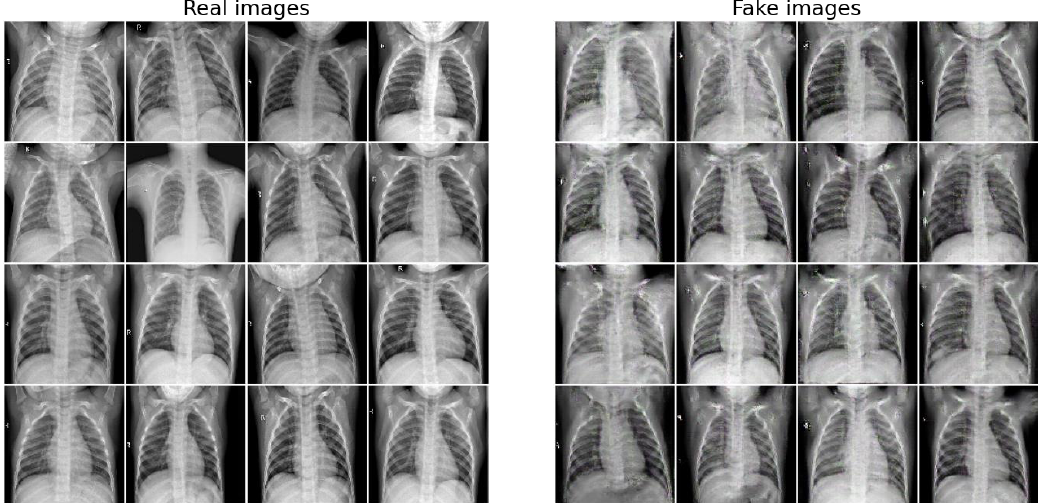
Figure 5. Images from the original dataset (real) and images generated by the generator of DCGAN (fake).